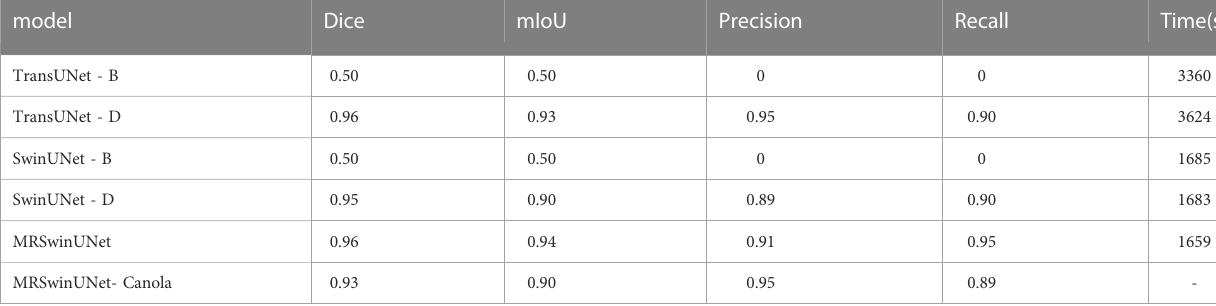
the red box of Figure 4, the SwinUNet-D barely segmented any effective information on the root. The resultant map of MRSwinUNet segmentation was similar to the original label with suf fi cient detail.